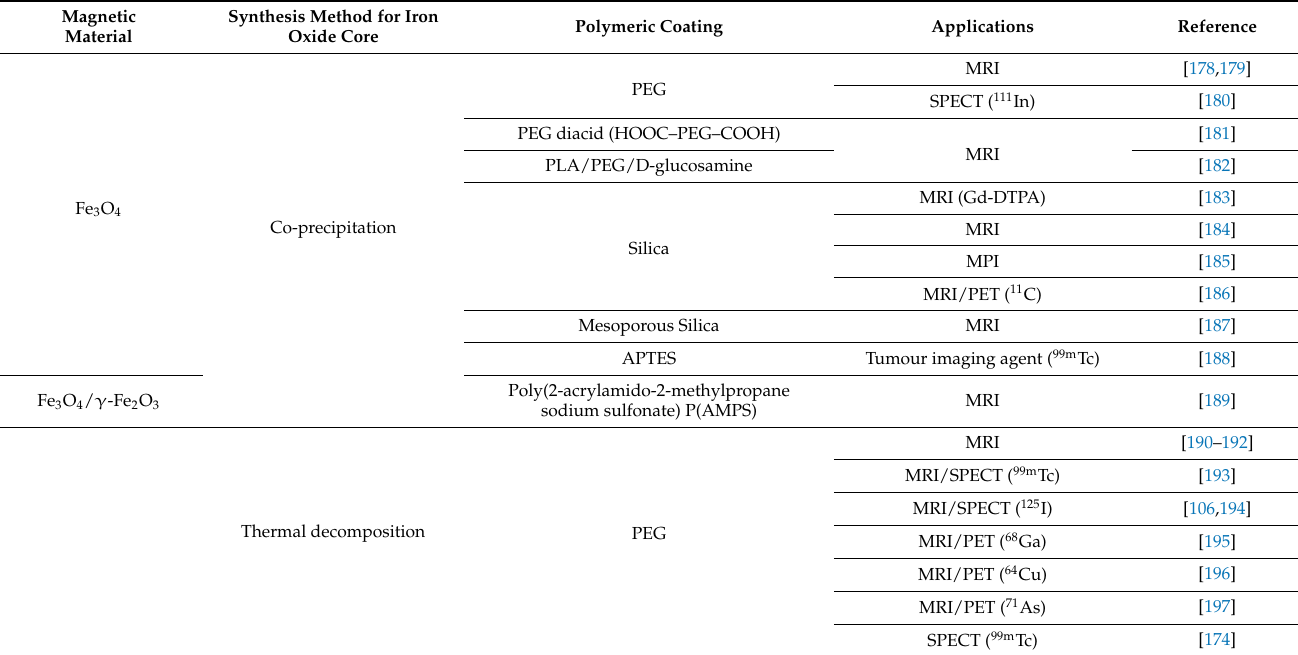
Table 5. Summarization of bio-inspired coating materials for iron oxide